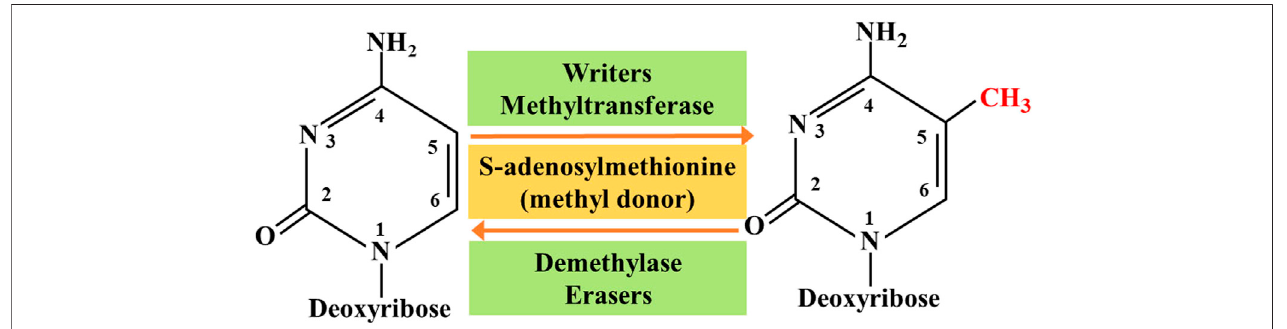
FIGURE 1 | Methylation interactions between writers and